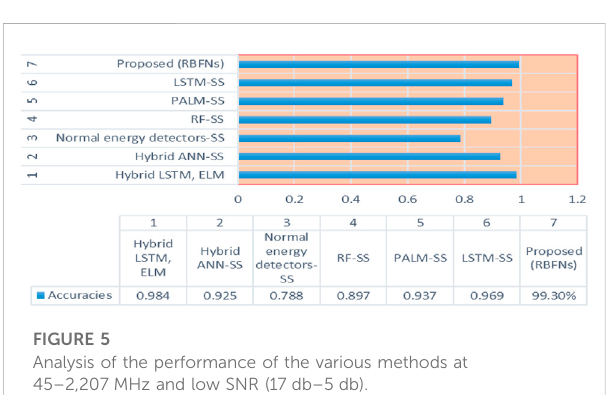
FIGURE 5 Analysis of the performance of the various methods at 45 – 2,207 MHz and low SNR (17 db – 5